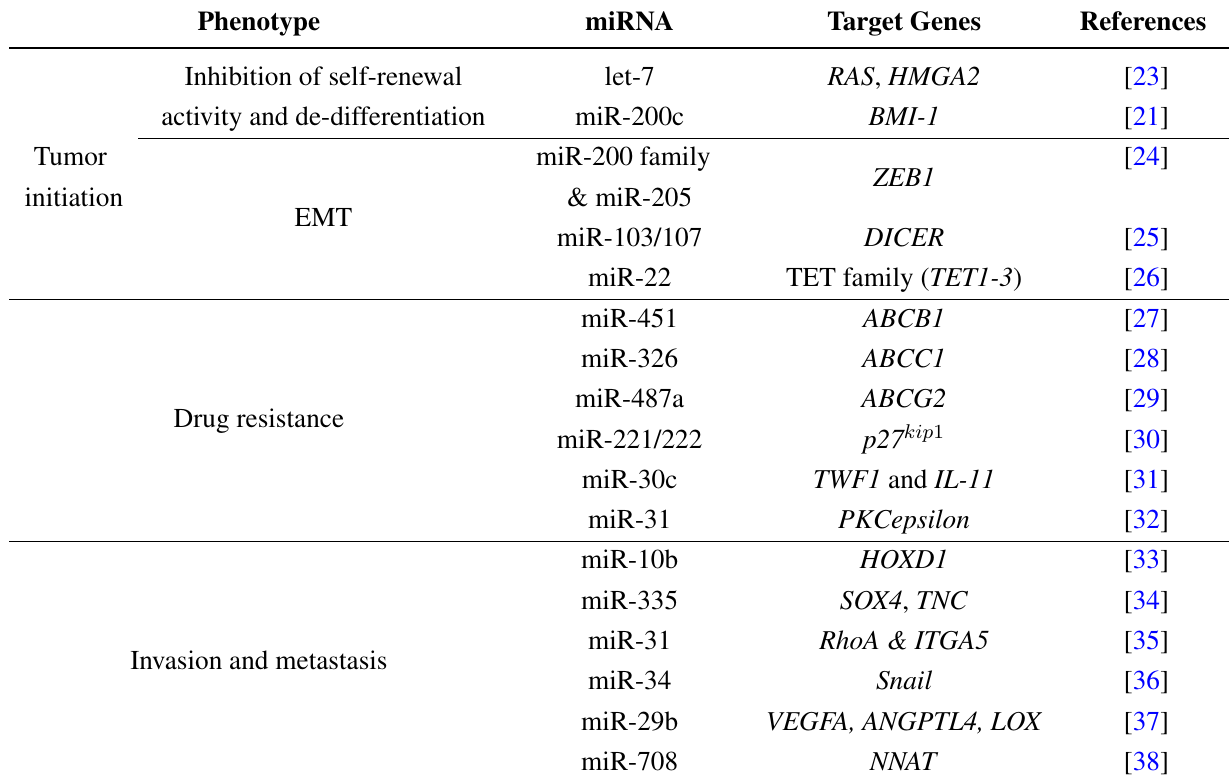
Table 1. The functions of miRNAs in breast